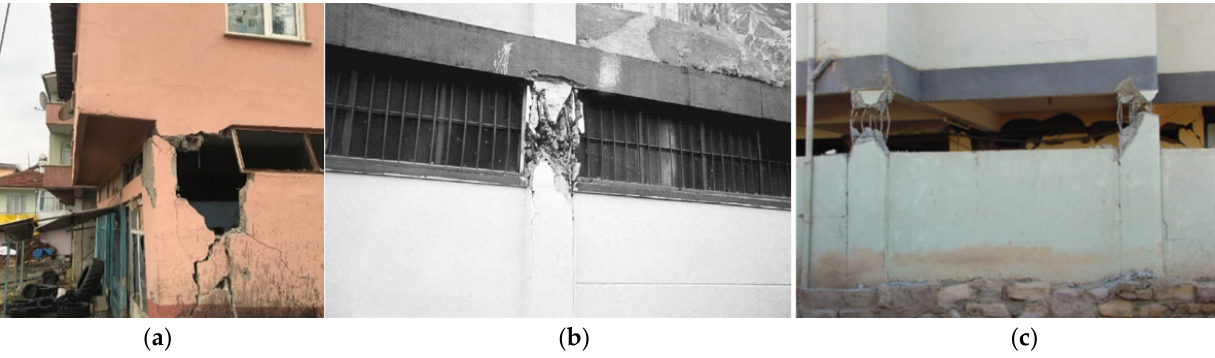
Figure 3. Short column damages: ( a )-24 January 2020 Elaz ı ğ earthquake [48], ( b )-25 January 1999 Armenia Colombia earthquake [49], ( c )-26 January 2001 (Bhuj) India earthquake [50].